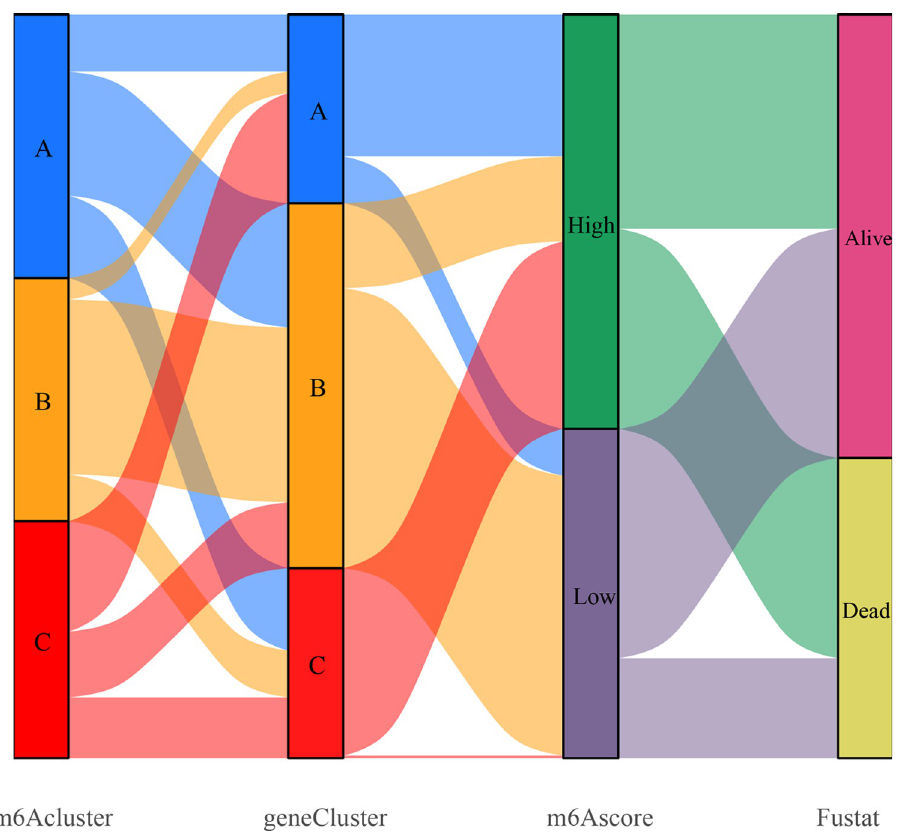
Fig 9. Genotyping m 6 A sang-froid. The first row indicates m 6 A cluster A, B, and C, the second row indicates gene cluster A, B, and C, the third row indicates high and low m 6 A scores, and the fourth row indicates survival status (alive, dead), with correlations indicated by connecting lines between different